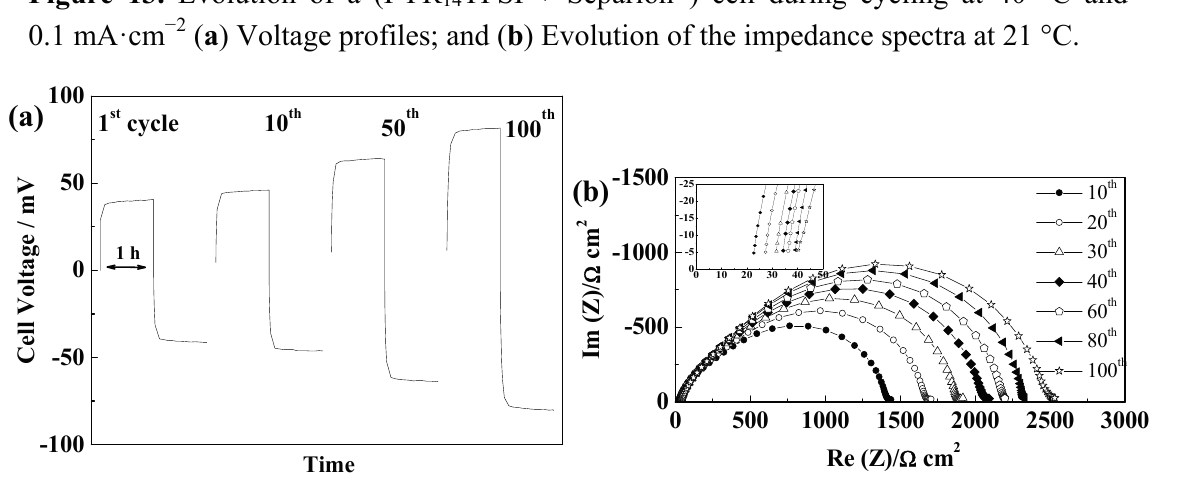
Figure 13. Evolution of a (PYR